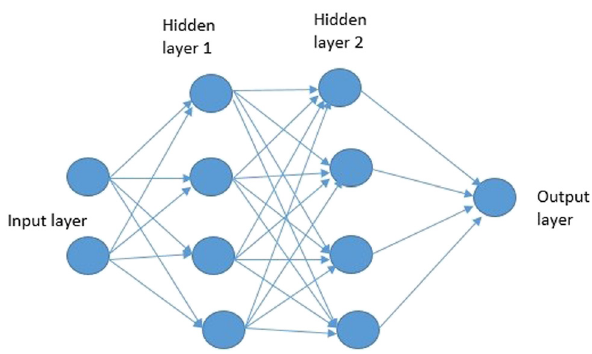
Figure 4: A typical representation of MLP with two hidden